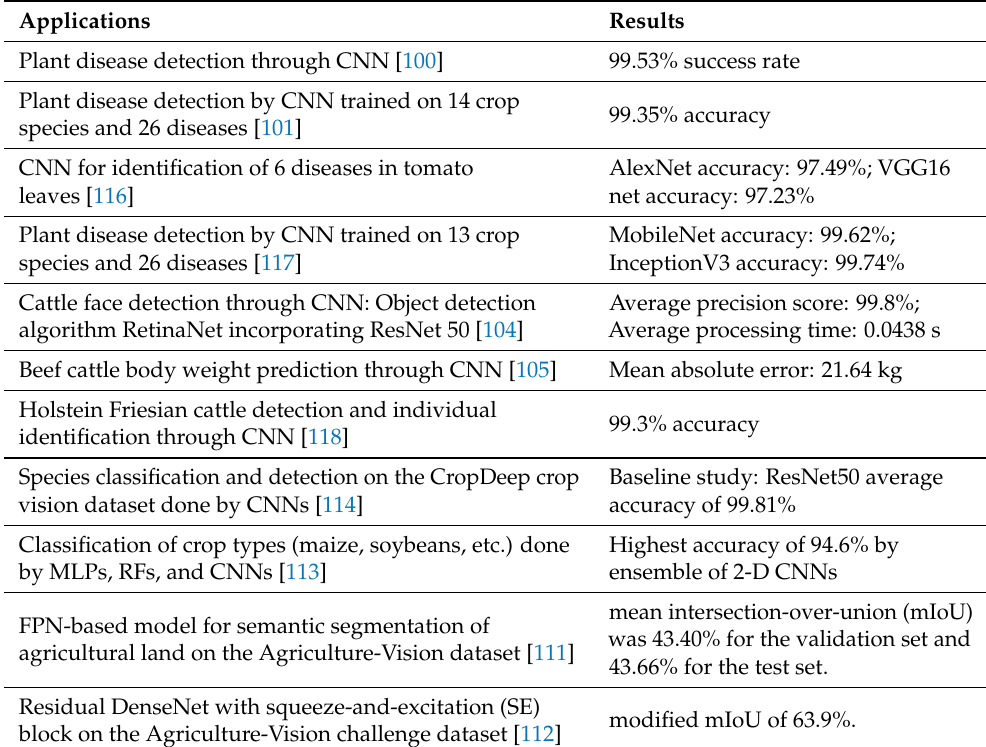
Table 2. Summary of applications of CNNs in smart